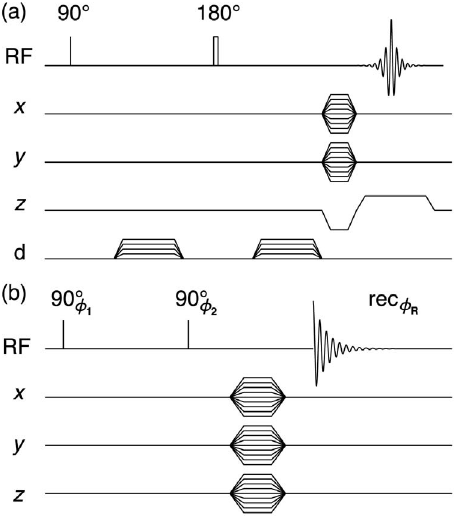
Figure 1. Schematic lamellar phase morphologies with corre- sponding diffusion tensors and 2 H spectra . Column 1: Lab frame coordinate system indicating the direction of domain alignment. The main magnetic field B 0 defines the direction of the z -axis. Column 2: Schematic lamellar phase domains with water and surfactant shown in blue and gray, respectively. Column 3: Diffusion tensors displayed as superquadrics [54]. Column 4: 2 H spectra with quadrupolar splitting D n Q ( a ) , see Eq. 3. Rows (a), (b), and (c): Uniform orientation with non- restricted water diffusion in the yz , xz , and xy -planes, respectively. Rows (d), (e), and (f): Domains oriented randomly along the curved arrow with main symmetry axis along z , x , and y -axes, respectively. Row (g): Random orientations in three dimensions. Row (h): Multi-lamellar vesicles (MLVs). Row (i): Mixture of MLVs and randomly oriented domains.